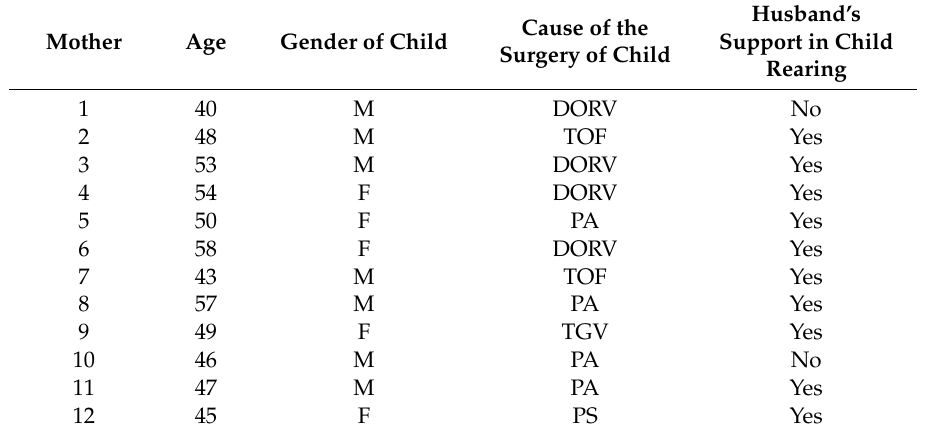
Table 1. General characteristics of the mothers and their children with complex congenital heart disease. Mother Age Gender of Child